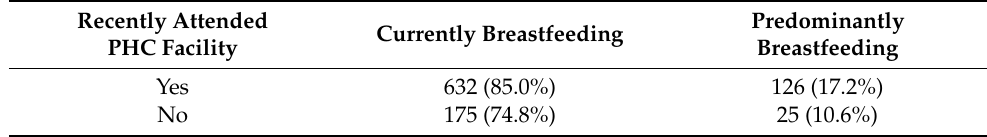
Table 2. Cross-tabulation of breastfeeding and attendance of PHC